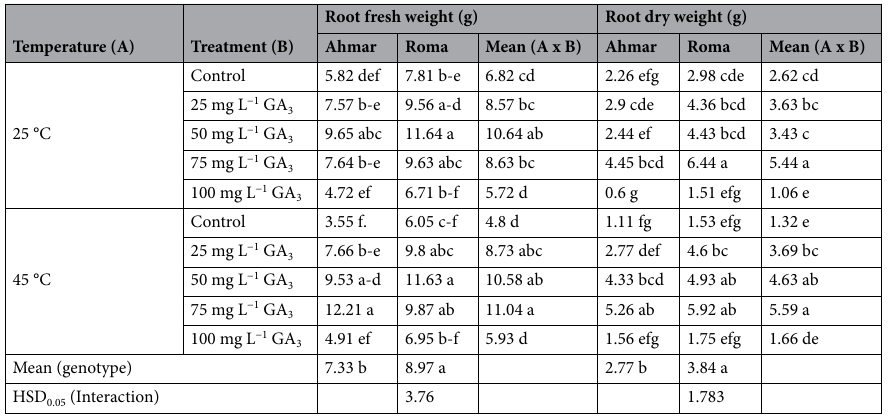
Table 3. Root fresh and dry weight of tomato as affected by temperature, genotype and exogenous application of GA 3 . According to Tukey’s honestly significant difference test, the same letters suggest that there is no statistically significant difference between treatments ( p ≤